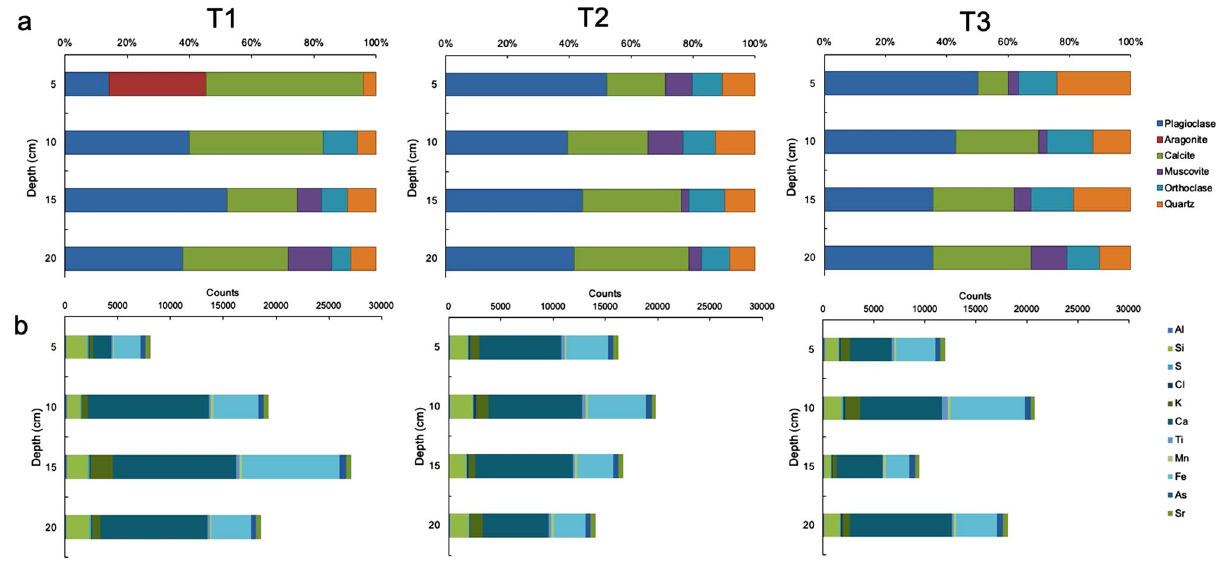
Figure 2. Mineralogy and Geochemistry of sediments. ( a ) Percentual composition of minerals and ( b ) Elemental composition (measured in counts) identified in sampling points in Salar de Tara T1, T2 and T3, through 20 cm depth records.